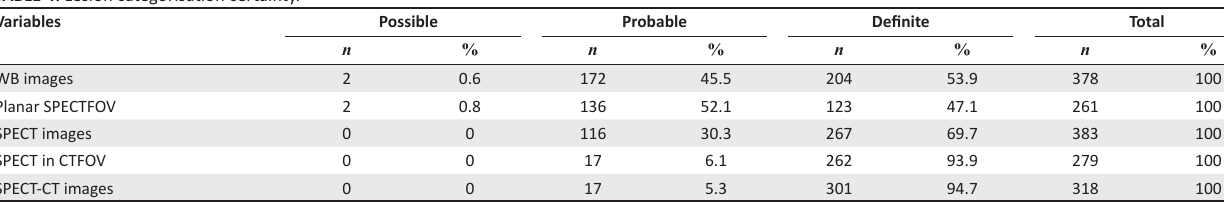
TABLE 4: Lesion categorisation certainty.